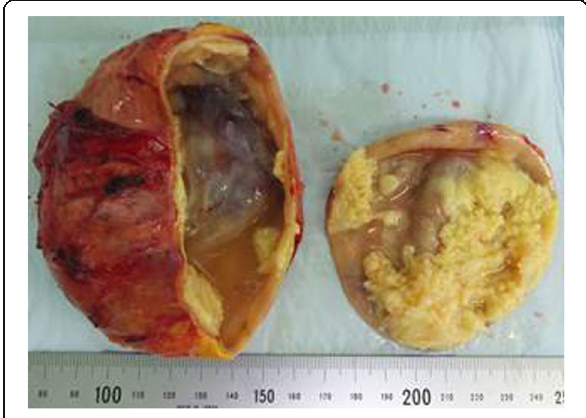
Fig. 2 Macroscopic finding. Macroscopically, the cystic tumor was approximately 100 mm in diameter with an interior that was almost necrotic and filled with turbid brown